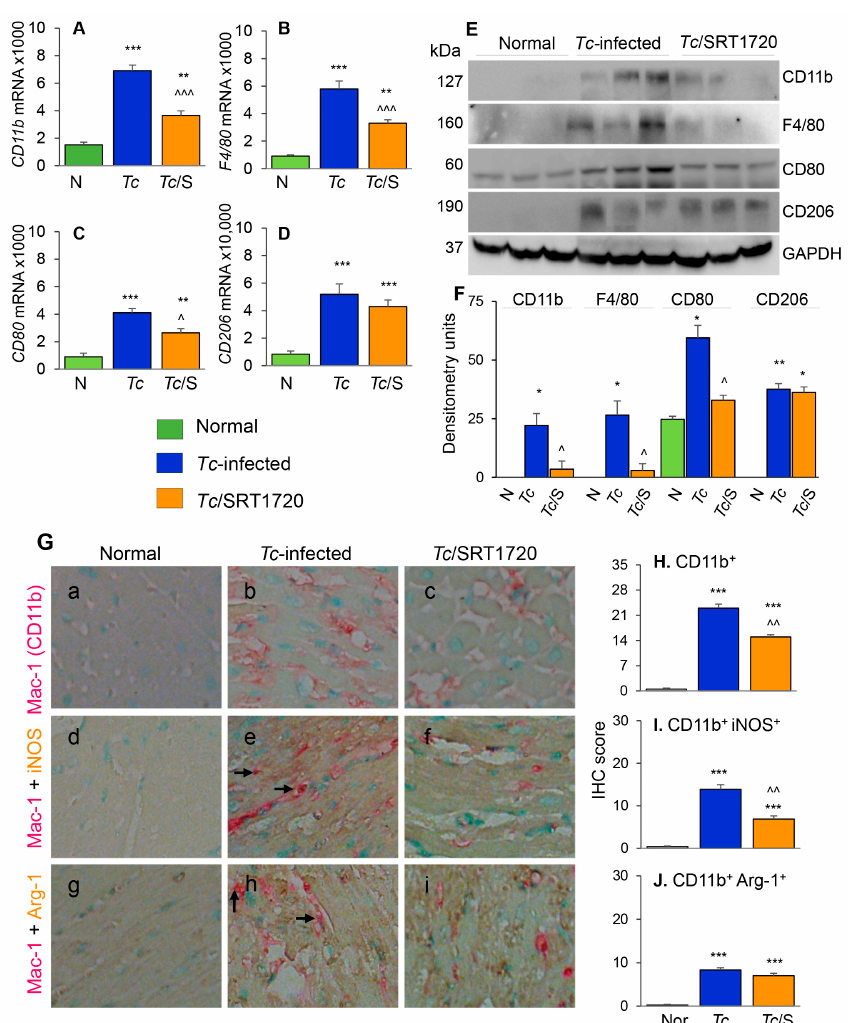
Figure 5. Phenotype of M φ infiltrating the myocardium of Chagas mice treated (or not treated) with SRT1720. Mice were infected, SRT1720-treated, and euthanized as in Figure 2A. ( A – D ) Myocardial tissue levels of mRNAs for CD11b, F4/80, CD80, and CD206 by real-time RT-qPCR. For each target gene, Ct values were normalized to GAPDH expression. ( E , F ) Shown are representative western blot images for cardiac levels of CD11b, F4/80, CD80, and CD206 in normal, Chagas, and infected/SRT1720-treated mice (loading control: GAPDH). Presence of dual bands for CD80 are likely due to post-translational modifications of the protein. Densitometry analyses of the western blot bands for target proteins, normalized to GAPDH, are shown in panel F. Data are presented as mean value ±SEM, derived from two independent experiments ( n = 3–5 mice per group per experiment, at least duplicate observations per mouse). ( G ) Paraffin-embedded heart tissue sections were subjected to immuno-staining with antibodies against Mac1/CD11b (Mo/M φ marker, pink color, ( G (a–i)), iNOS (M1 Mo/M φ marker, brown color, ( G (d–f)), and Arg-1 (M2 Mo/M φ marker, brown color, ( G (g–i)). Shown are representative images of heart tissue of normal ( G (a,d,g)), Chagas ( G (b,e,h)), and infected/SRT1720-treated ( G . (c,f,i)) mice. Arrows indicate the pink/brown staining of Mac1/CD11b with iNOS or Arg-1. ( H – J ) Bar graphs show average immunohistochemistry (IHC) score ± SEM for CD11b + ( H ), CD11b + iNOS + ( I ), and CD11b + Arg-1 + ( J ) phenotype in heart tissue sections ( n = 3 mice per group, 2–3 tissue sections per mouse, 9–10 microscopic fields per tissue section). Statistical significance is plotted as * normal vs. infected groups, and ˆ Tc vs. Tc / SRT1720. * or ˆ p value < 0.05; ** or ˆˆ p value < 0.01; and *** or ˆˆˆ p value <